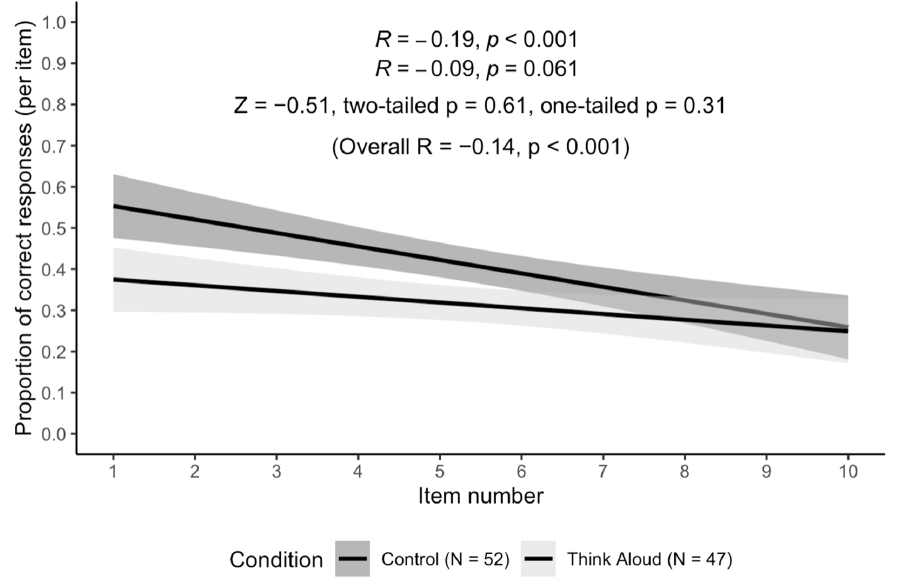
Figure A1. Practice effect tests in Study 1 (N = 99). Performance did not increase but decreased during the survey. The magnitude of this decrease was not dramatically different between conditions (Z-score). Error bands indicate standard